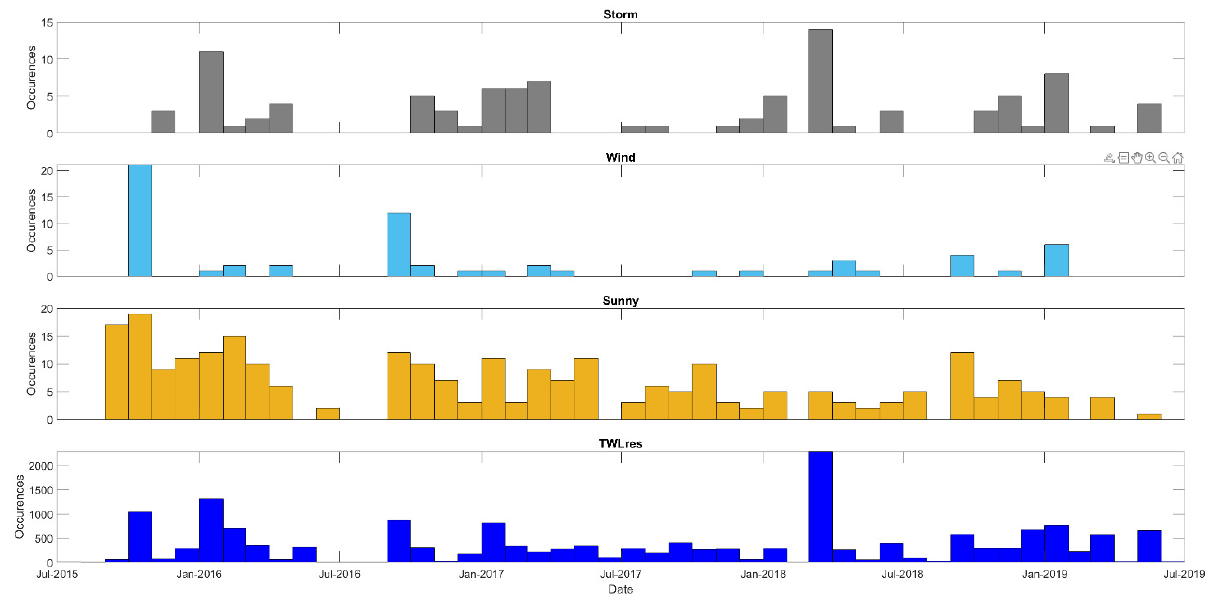
Figure 6. Occurrences of threshold exceedances based on the storm, wind, sunny, and TWL res 95% criteria. The bar widths are one